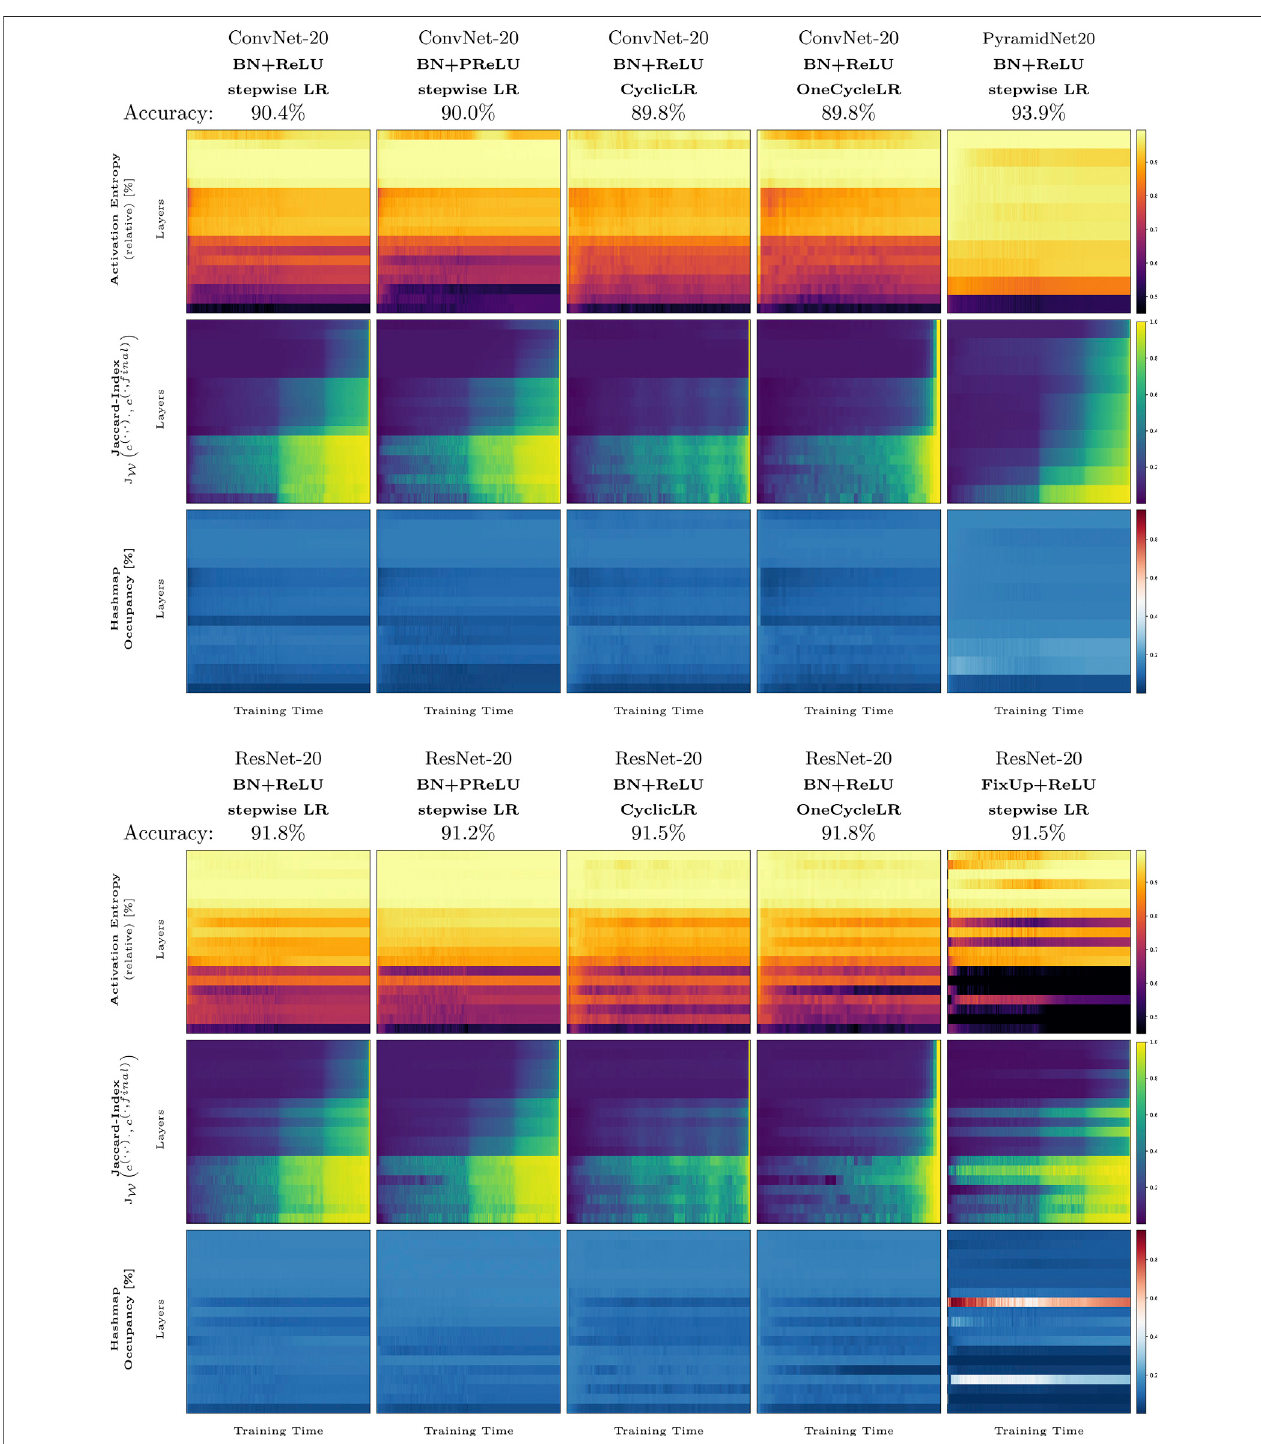
FIGURE 3 | Complete training runs for several methods and architectures: ConvNet-20, ResNet-20, PyramidNet-20, FixUp, cyclic, and one-cycle learning rate schedulers. Each plot shows a measure based on activation pattern distributions throughout the whole training (x-axis) for all activation layers in each network (y-axis). The fi rst row shows the activation entropy, the second row shows the Jaccard index between the current network state during training and the fi nal network state, and the third row shows the hash list occupancy used to compute the distributions.